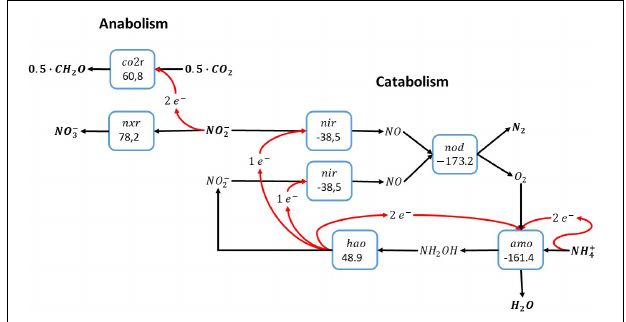
FIGURE 3 | Ammonia oxidation with nitrite as electron acceptor via intracellular production of molecular oxygen (Raghoebarsing et al., 2006). This overall reaction is equivalent to the anammox reaction as shown in Figure 1 . The individual blocks represent enzymatic steps ( nod , nitric oxide dismutase; nir , nitrite reductase; amo , ammonia monooxygenase; hao , hydroxylamine dehydrogenase; nxr , nitrite oxidoreductase; co2r , CO 2 fixation) and the corresponding Gibbs free energy change of the reactions corrected for a pH of 7 ( (cid:52) G 0 (cid:48)